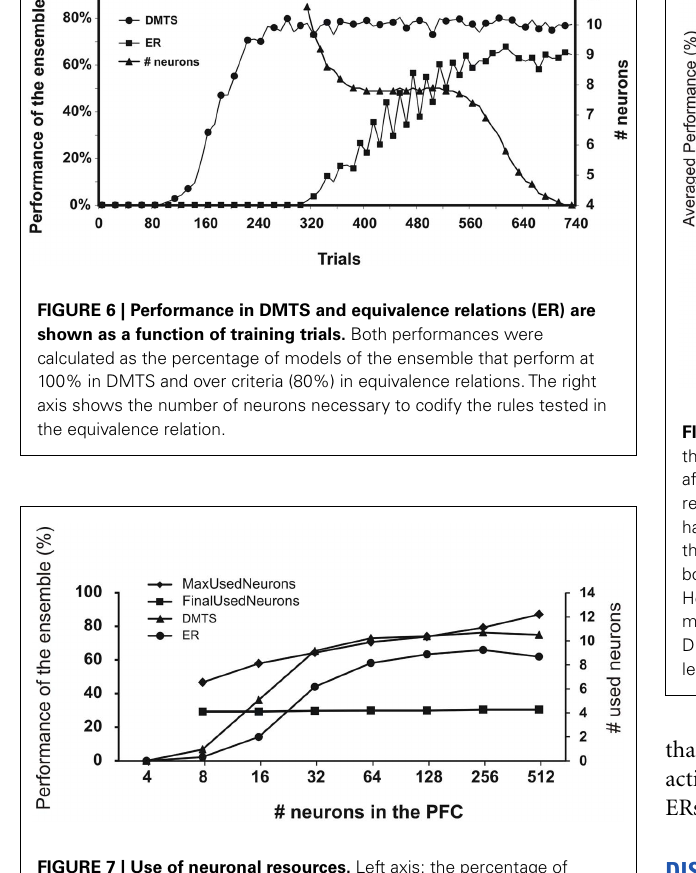
FIGURE 7 | Use of neuronal resources. Left axis: the percentage of models in the ensemble that reaches criteria in DMTS and ER test is shown as a function of the number of neurons in the PFC. Right axis: number of neurons in the PFC that won at least once during the training phase (MaxUsedNeurons) and the number of neurons in the PFC that won at least once in the last 100 trials of the training phase (FinalUsedNeurons).